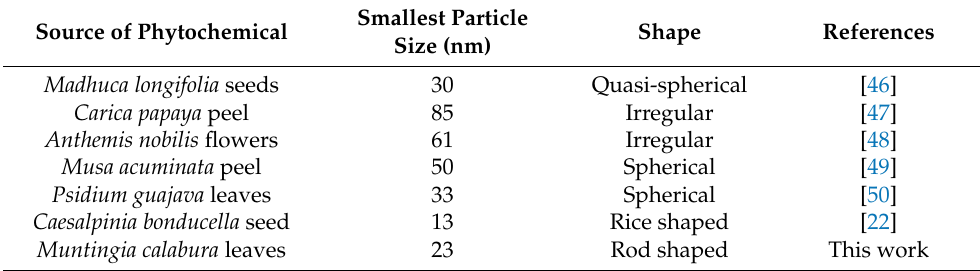
Table 2. Comparison of morphological properties of CuO NPs derived from M. calabura leaves with recent literature.